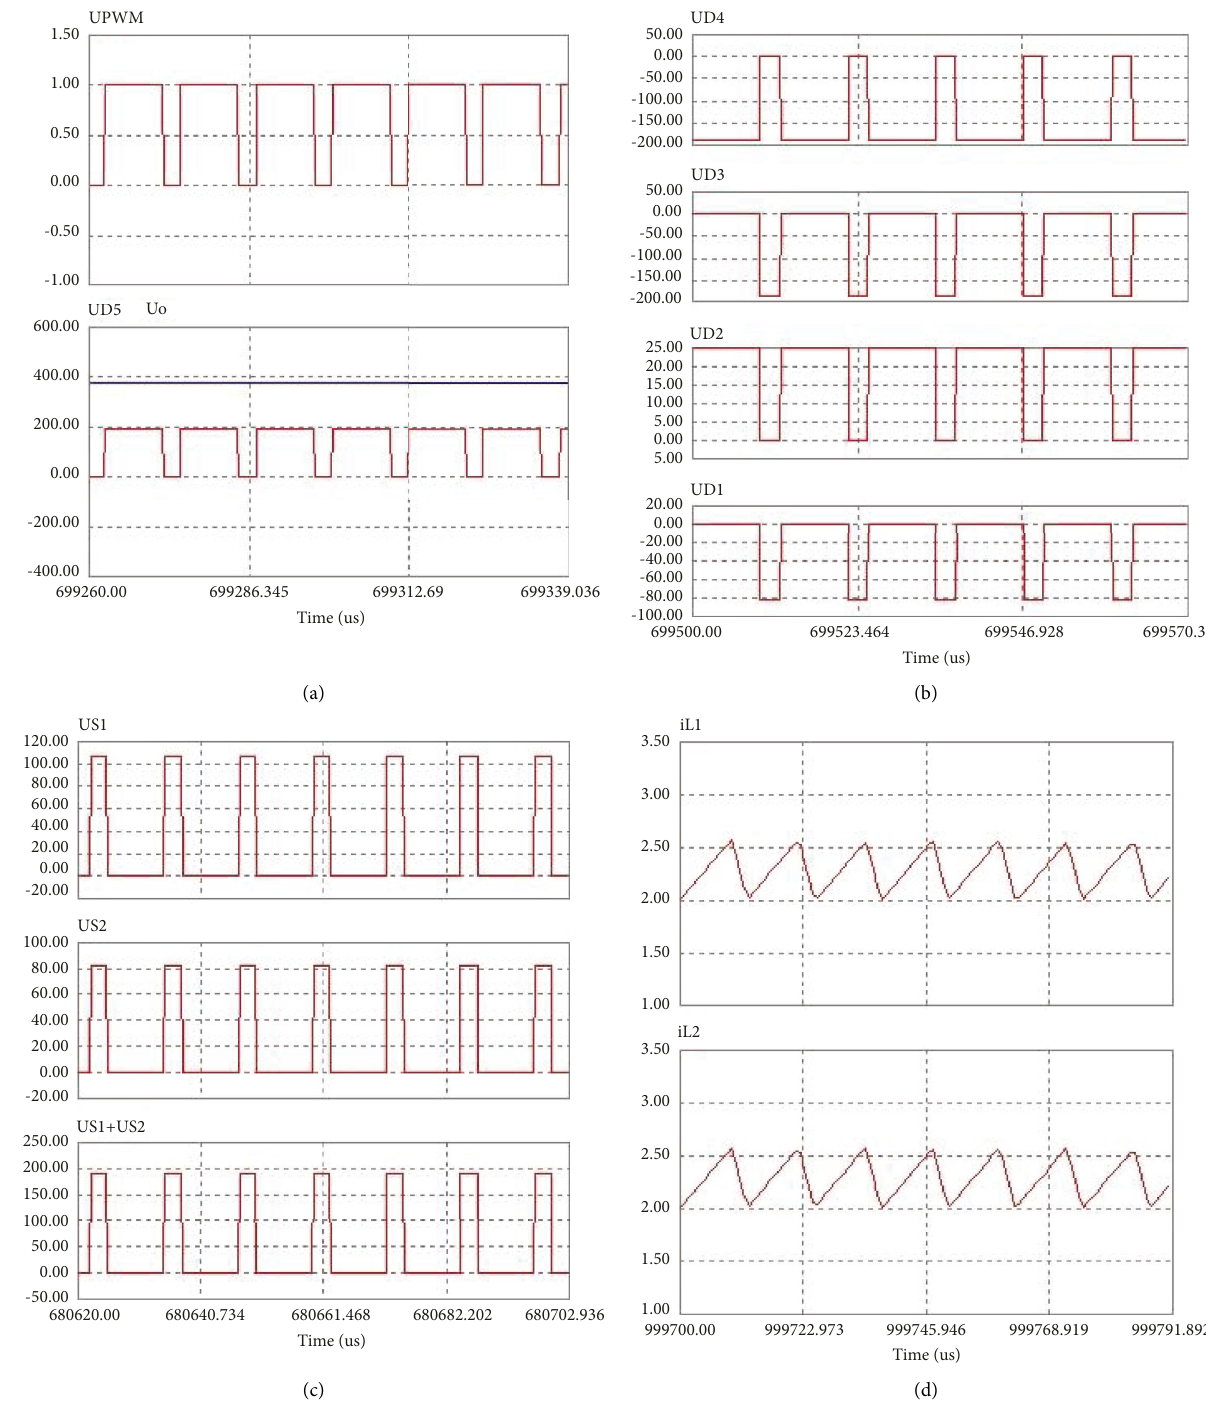
Figure 12: Simulation results when V currents of L1 and